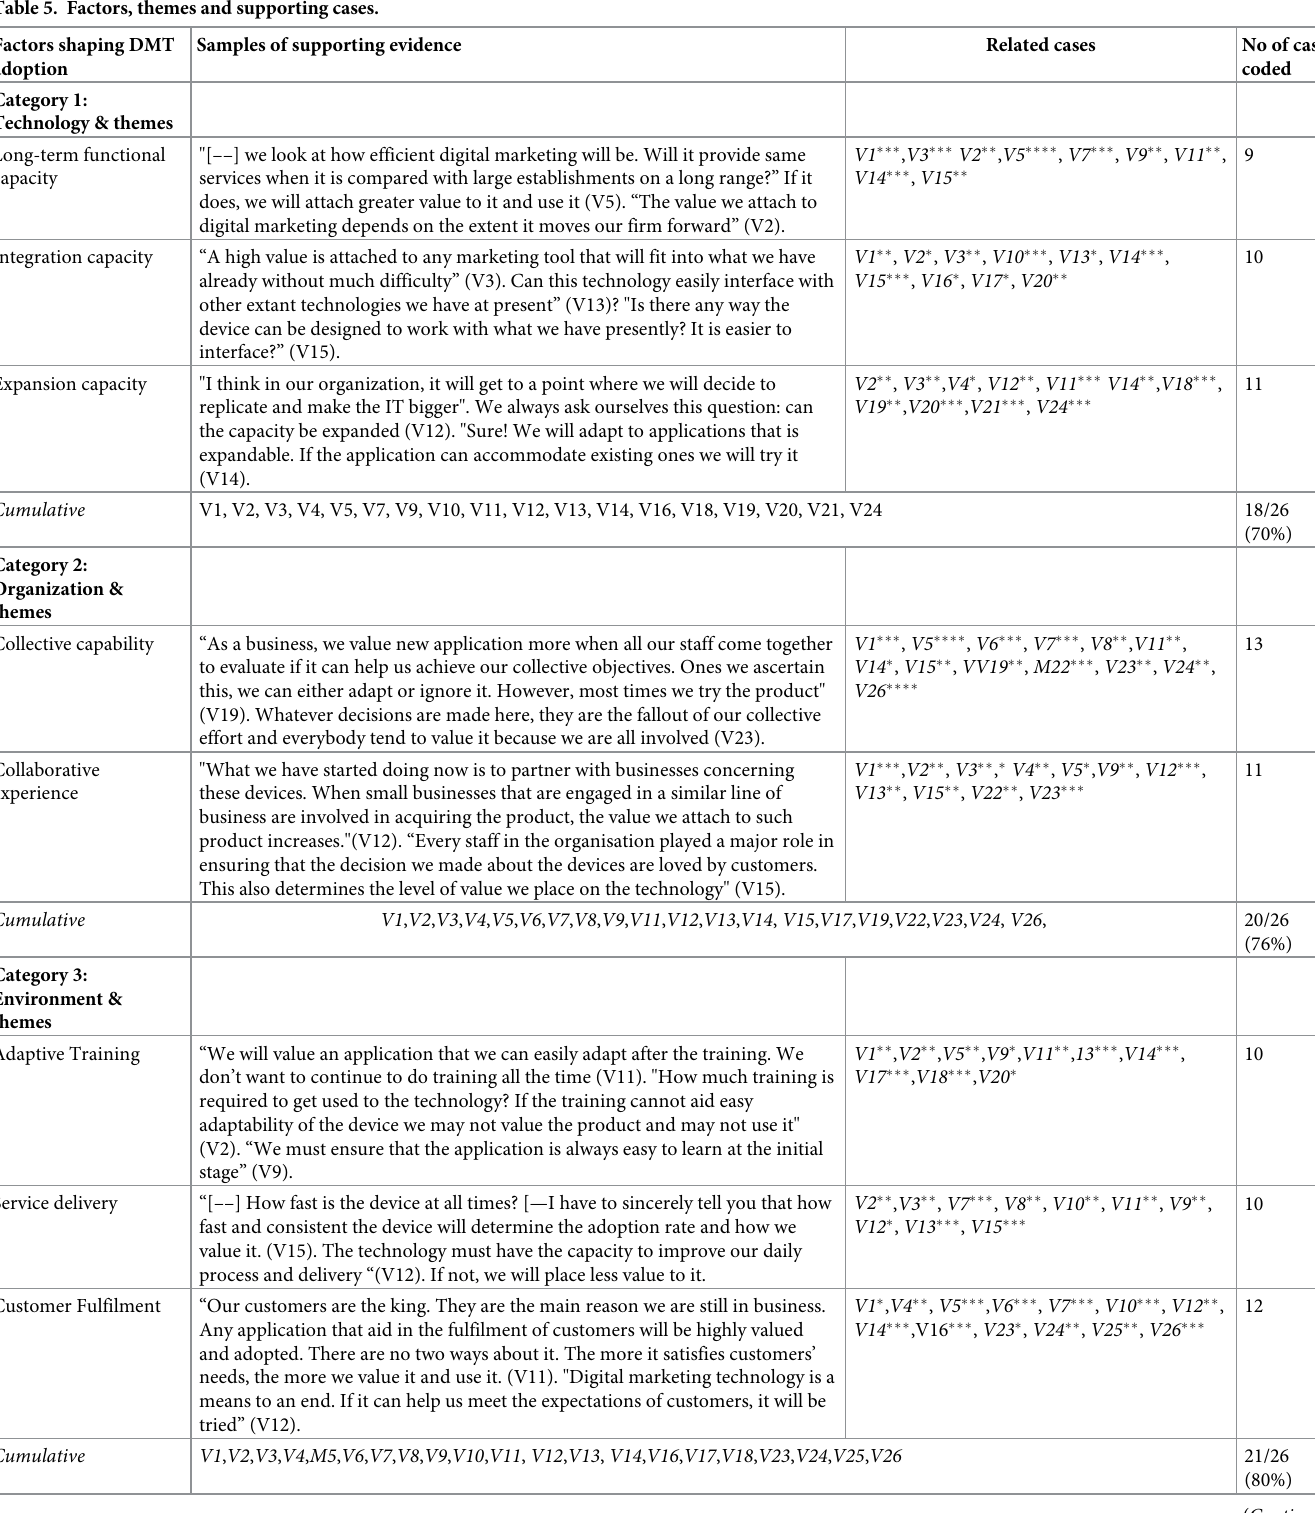
Table 5. Factors, themes and supporting